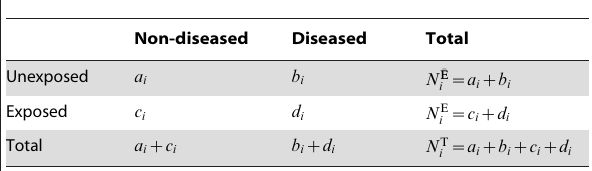
Table 2. Re-analysis of the mortality data from all causes for tolbutamide and placebo treatment groups a